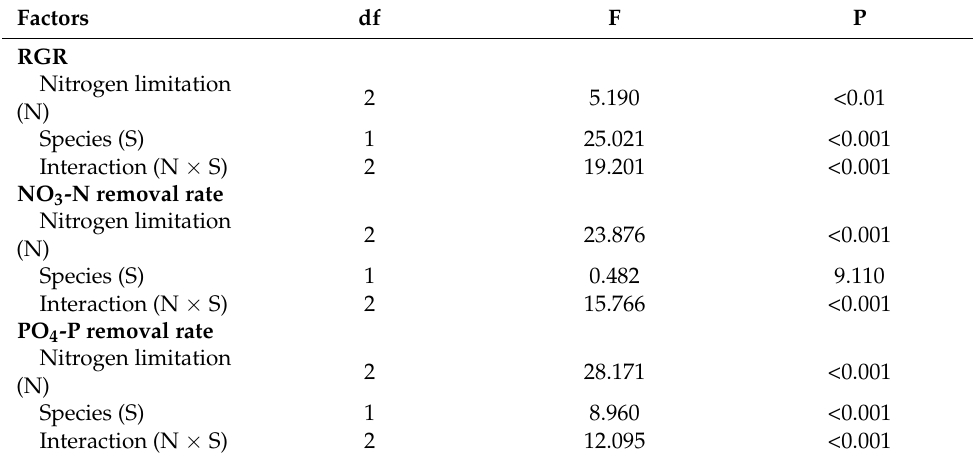
Figure 3. The RGRs and NO 3 -N and PO 4 -P removal rates of N. haitanensis and N. dentata cultured for 4 days after three different periods of nitrogen limitation. Different capital and small letters indicate statistical significance ( P < 0.05) among species and nitrogen limitation periods, respectively.The data represents the mean ± SE (n = 3 replicates). Table 3. Analysis of variance (two-way ANOVA) examining the effects of nitrogen limitation on the RGR and NO 3 -N and PO 4 -P removal rates of N. haitanensis and N. dentata , and the comparison of these parameters between the two